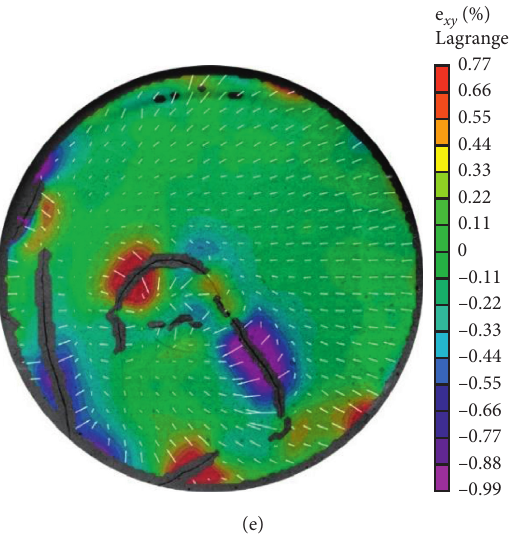
Figure 7: An example of DIC results of soils calculated by Vic-2D at t � 19.2h. (a) Longitudinal displacement U ; (b) transversal dis- placement V ; (c) longitudinal strain ε xx ; (d) transversal strain ε yy ; and (e) shear strain ε xy .